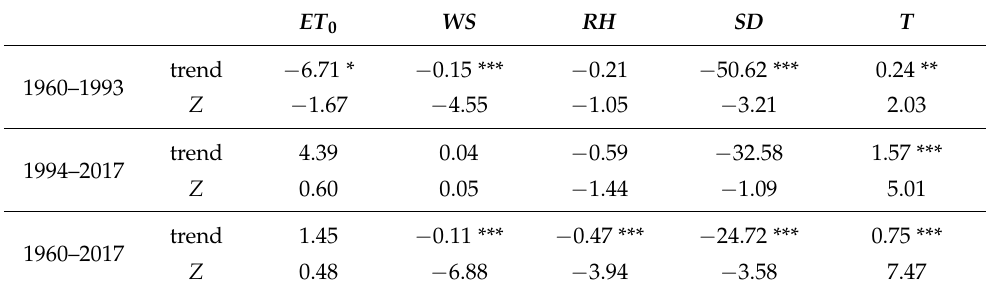
Figure 2. ( a ) Interannual variations of ET 0 in Northeast China and ( b ) results of mutation detection in temporal variation in annual ET 0 over Northeast China during 1960–2017 by Cramer’s test. The horizontal black lines are the 0.01 significance level line. The red point indicates the mutation year. Table 1. The change trends of ET 0 and climatic variables in Northeast China during